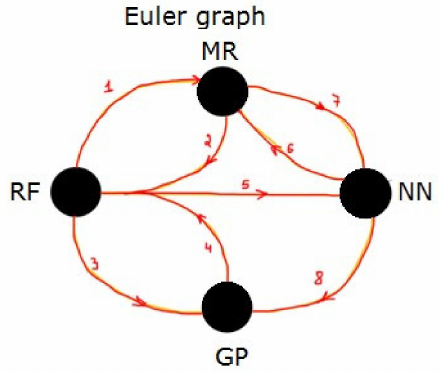
Figure 8. Euler graph method of machine